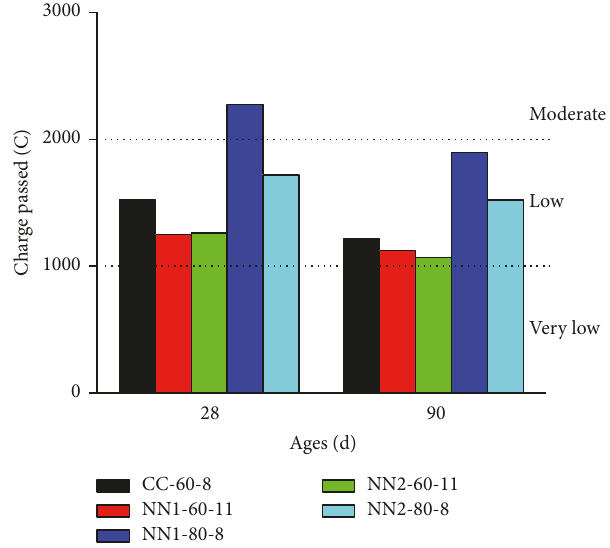
Figure 25: Chloride ion permeability of the steam-cured concrete with W/B of